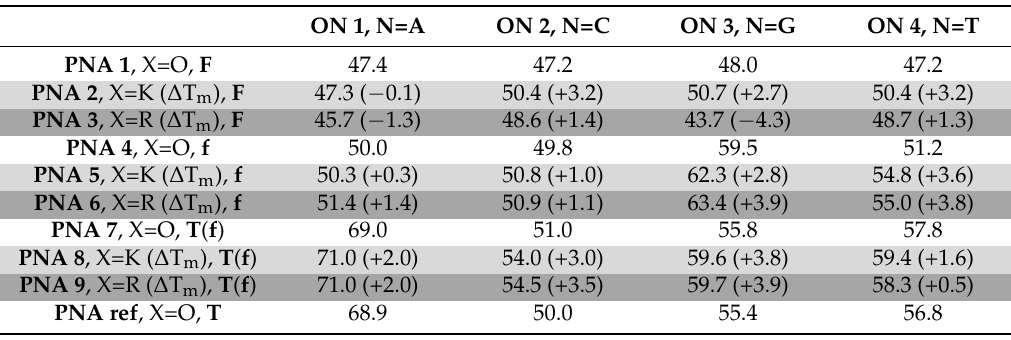
Table 1. Melting temperatures (T m ) for PNA:DNA, measured by UV absorbance at 260 nm in PBS buffer at pH 7. Strand concentration: 5 µ M. PNA sequence: Ac-GGG CA X GAT CT-Gly-NH 2 , where X stands for the modified monomer ( O , K , R , F , f , T ( f ) see Figure 1 for structural details), DNA sequence: 5 (cid:48) -AGA TCN TGC CC-3 (cid:48) , where N=A ( ON 1 ), C ( ON 2 ), G ( ON 3 ) or T ( ON 4 ). Numbers inside parentheses indicate the T m difference with respect to T m s obtained for the sequences with unmodified backbone ( PNA 1 , PNA 4 and PNA 7 ). Data for PNA ref (Ac-GGGCATGATCT-Gly-NH 2 ) are from [47]. Light grey lines indicate PNAs bearing a lysine side chain modification, dark grey lines indicates PNAs bearing an arginine side chain